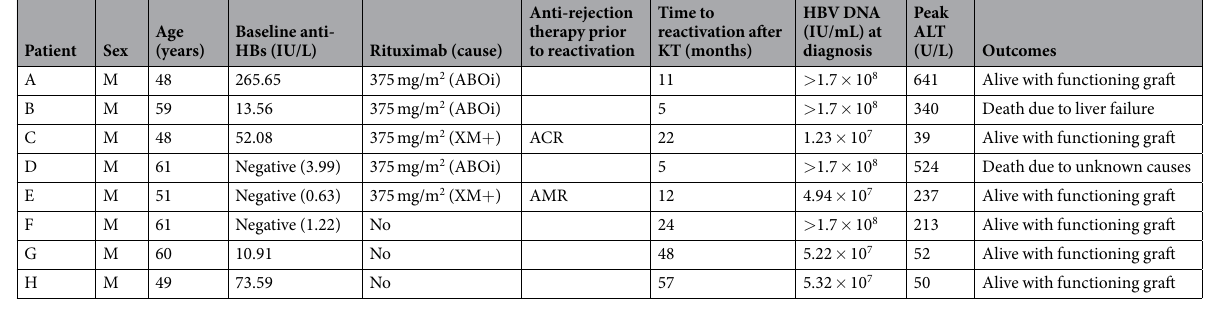
Table 2. Clinical outcomes of HBV